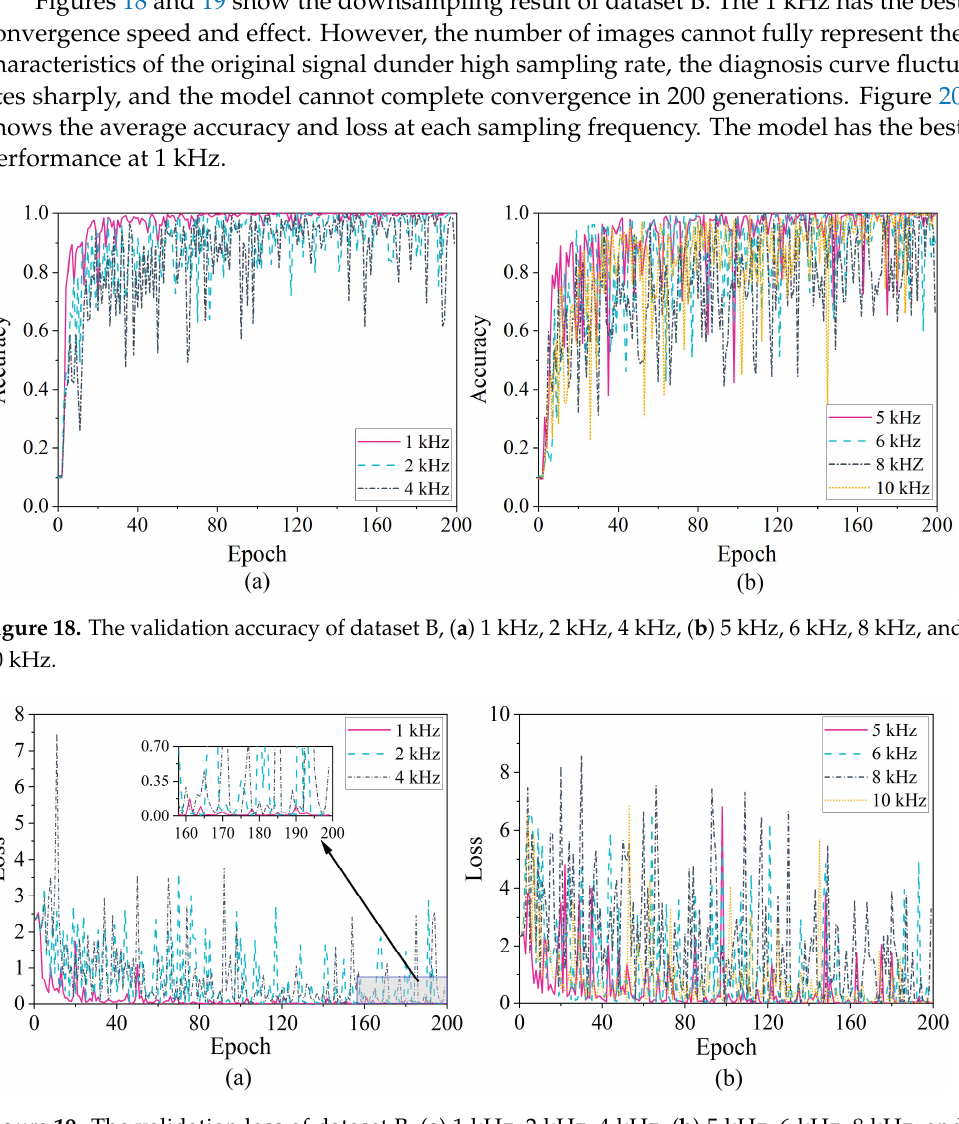
Figure 20. The accuracy and loss of dataset B.